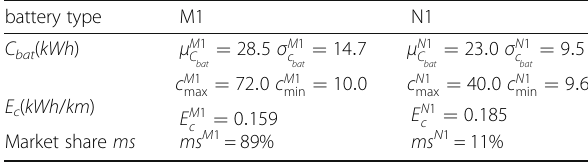
Table 2 PEV battery capacity